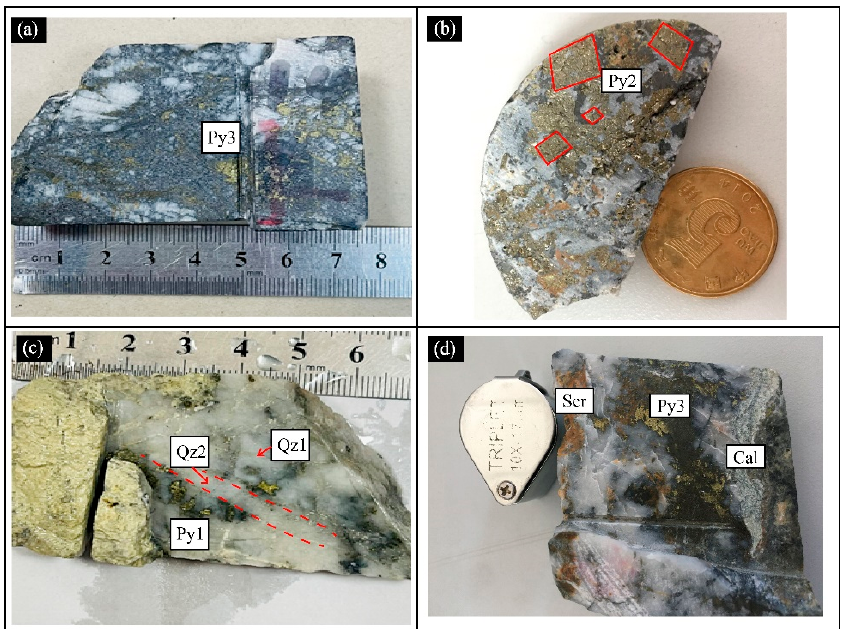
Figure 2. ( a ) Map of metallogenic belt distribution of Fang’an gold deposit, modified after [16]; ( b ) location of sampled drill holes projected onto the I metallogenic belt; ( c ) cross-section of No.16 ex- ploration line in the Fang’an gold deposit, modified after [16] and No.312 Unit of Bureau of Geology and Mineral Exploration of Anhui Province.